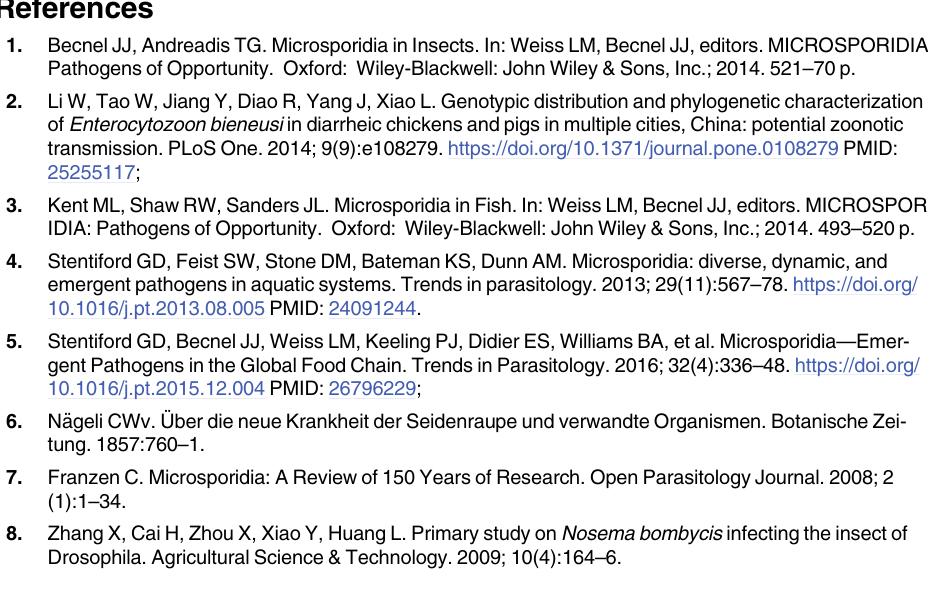
S1 Fig. Labeling the proliferative phase of microsporidian by immunofluorescence histo- chemistry in oviduct epithelial tissue slices. β - Tubulin antibody coupled with Alexa Fluo 594 labeled secondary antibody was used to label the proliferative phase of microsporidia. DAPI (blue) were used to stain the nucleus. (Bars = 10